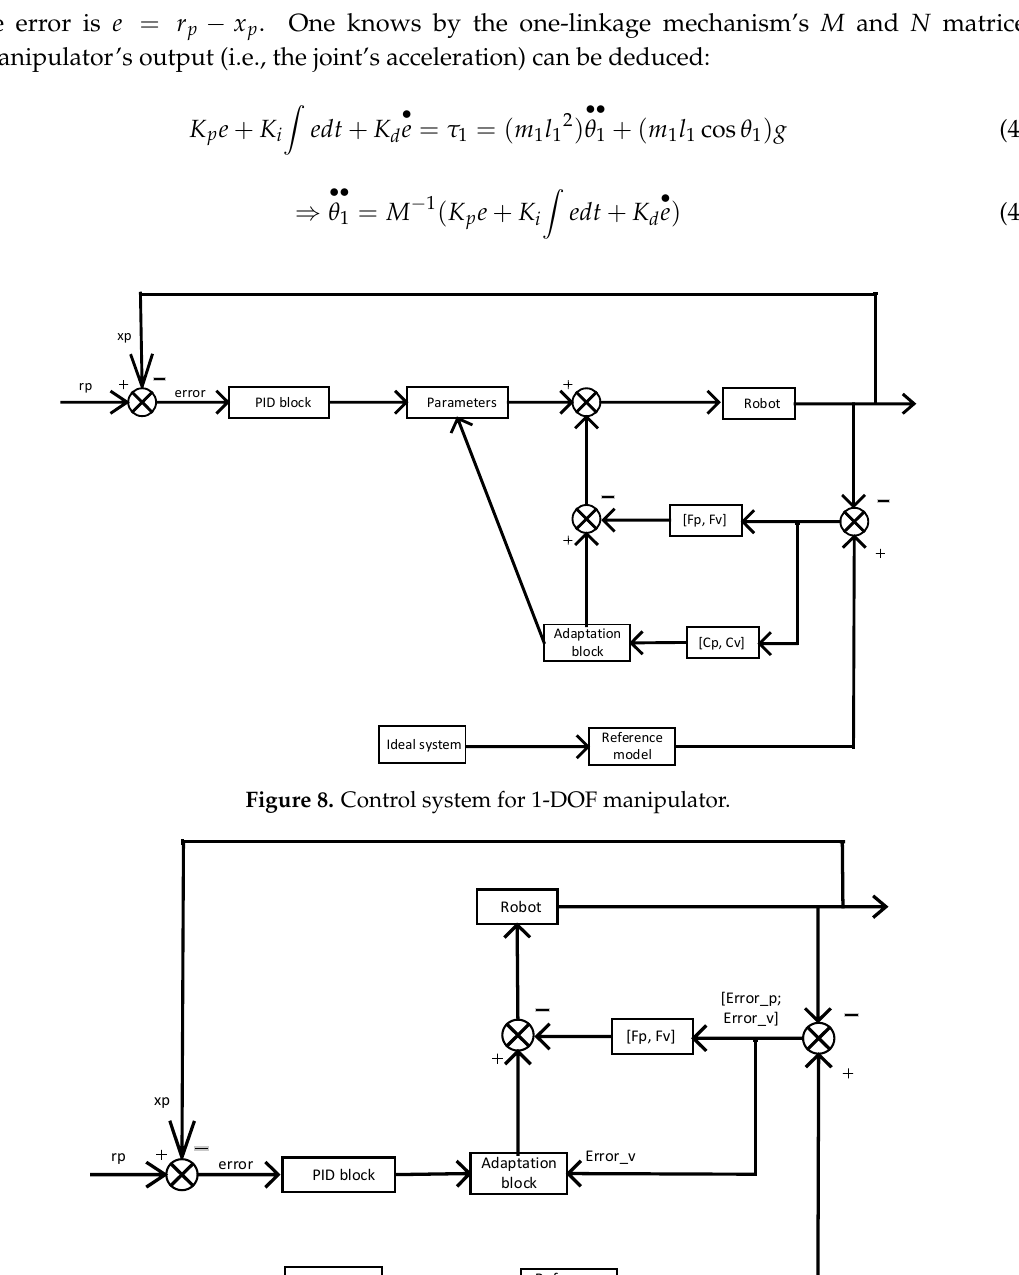
− Control law Figure 7. Adaptive control structure. 3. Hyperstability Approach 3.1. PID+MRAC Control Through incorporating the PID and model reference adaptive controls, a PID+MRAC structure is developed as shown in Figure 8. The synthesis of the PID+MRAC controller is based on the hyper- stability theory. The output from the manipulator compares to the output of the reference model, which will result in a difference. This difference is utilized by the adaptation section to tune the